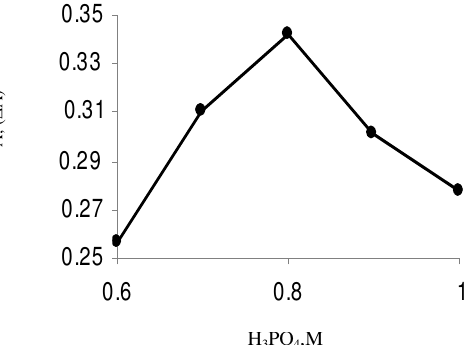
Figure 3. Effect of H PO concentration on the sensitivity. Conditions: 100 ng/mL 3 4 vanadium(V); Triton-x-100 0.01 M; MG 1.07 × 10 -5 M M; BrO 3− , 8 × 10 -3 M; temperature, 23 °C and time of .5-2.0 min from initiation of the reaction